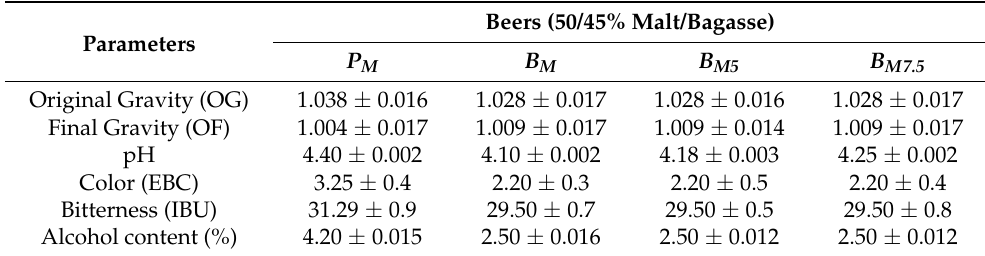
Table 1. Physicochemical parameters of beers with 100% malt (P M ), malt bagasse (B M ), malt bagasse with 5 mL/L of A CE * (B M5 ), and malt bagasse with 7.5 mL/L (B M7.5 ) of A CE . Beers (50/45% Malt/Bagasse) Parameters P M B M B M5 B M7.5 Original Gravity